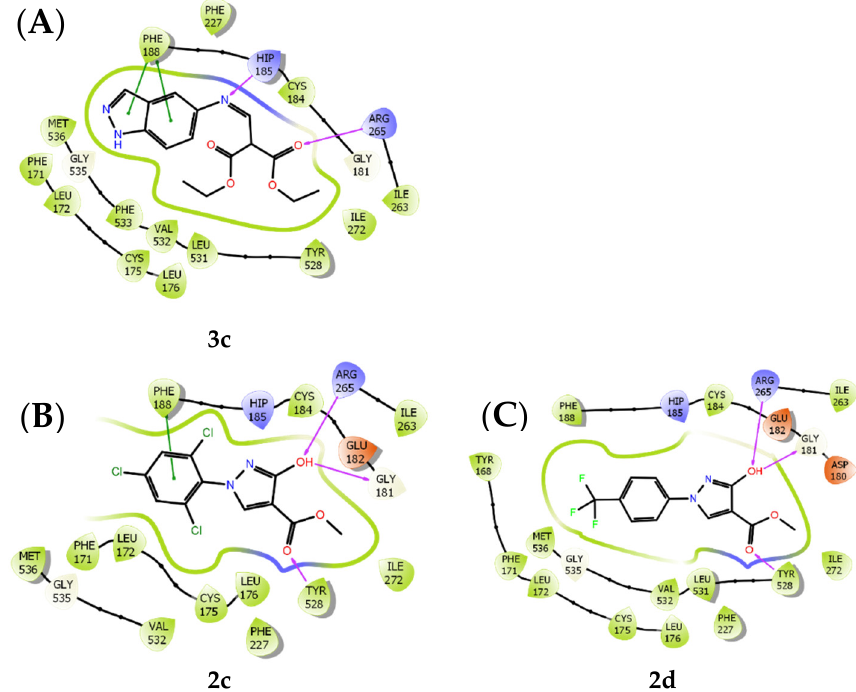
Figure 6. Molecular docking of compounds 3c ( A ), 2c ( B ), and 2d ( C ) into the coenzyme-binding site of Pf DHODH.